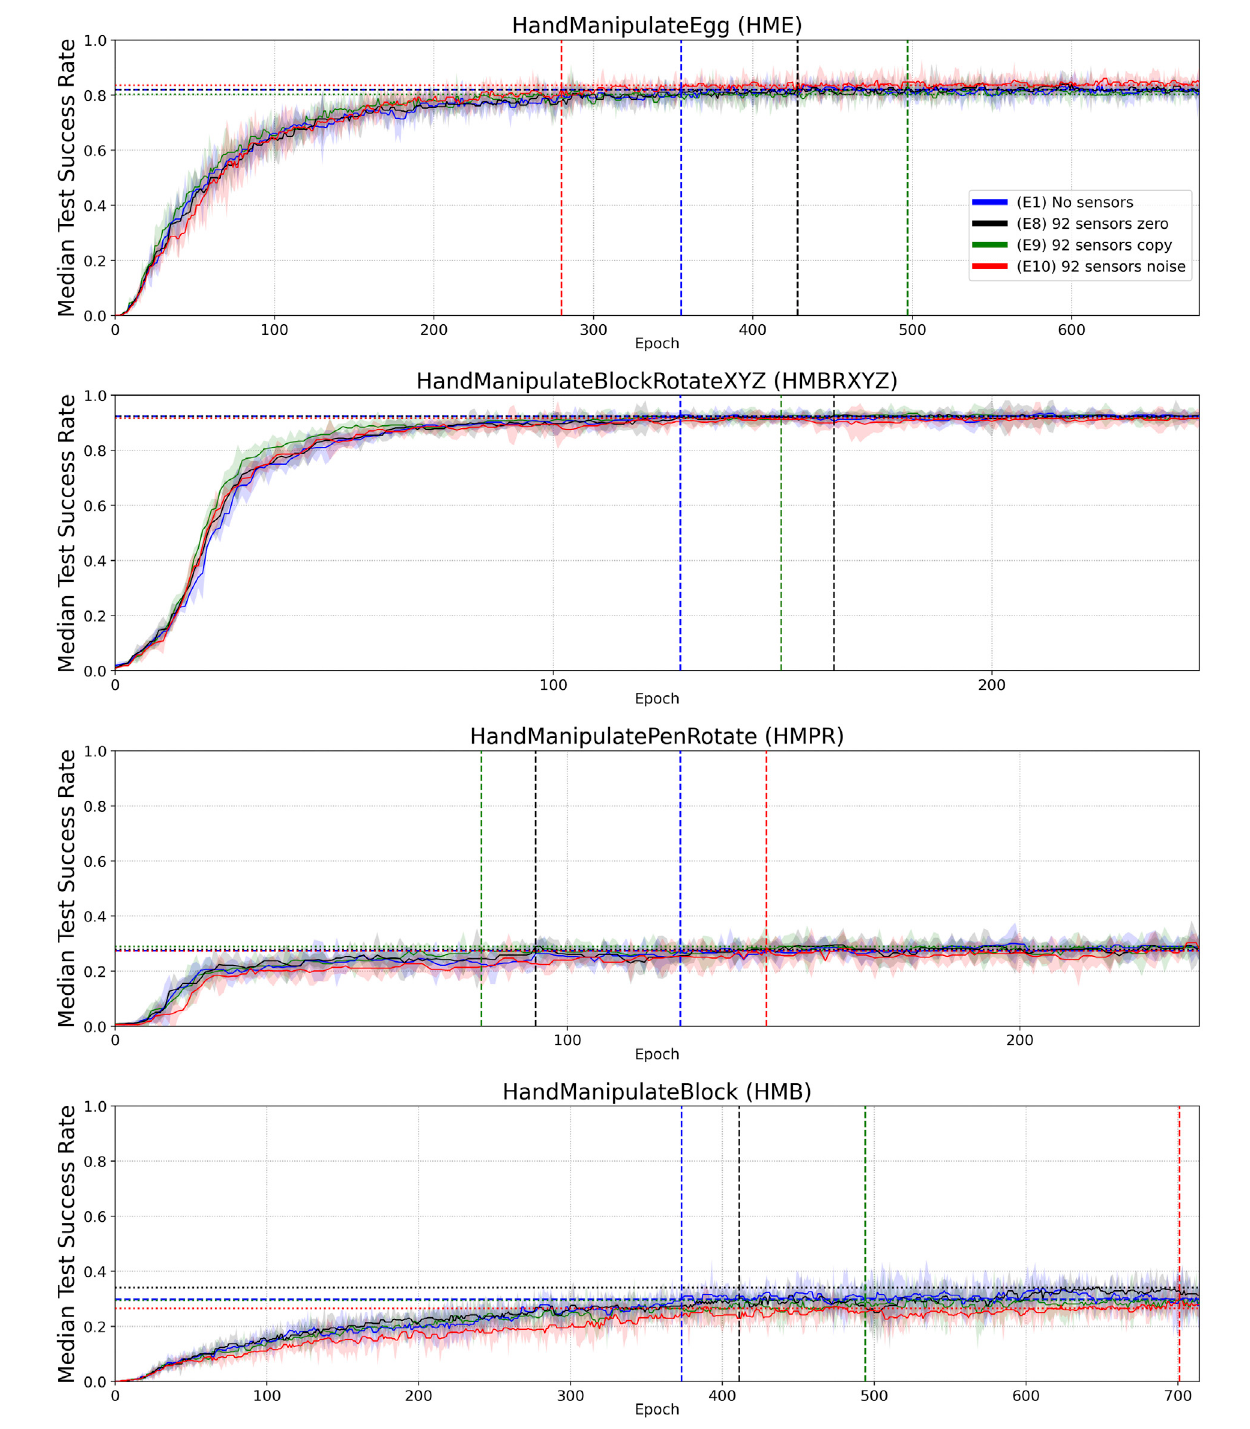
FIGURE 6 | Similar to Figure 4 , but for Experiments E8 (black — 92 sensors zero), E9 (green — 92 sensors copied) and E10 (red — 92 sensors noise), with Experiment E1 (blue – no sensors) included again for reference. Median Success Rate curves (vertical axes) vs. training epochs (horizontal axes). Each curve shows the mediansuccessrateacross fi vedifferenttrainingtrialswithadifferentrandomseed.Thesuccessratevalueineachtrainingtrialisthemeanof10testsaftereachtraining epoch.Themediansmoothingwindowofplottedcurvesisequalto fi veepochs.Shadedareasrepresenttheinterquartilerange.Horizontaldottedlineshighlightthe success-rate-convergence level of corresponding (color) curves ( Table 6 ). The blue horizontal dashed line highlights the success-rate-convergence level of learning without touch sensors (No sensors) ( Table 7 ). Vertical dashed lines (blue, black, green, and red) highlight the intersection of corresponding curves (color) with the blue dashed line ( Table 7